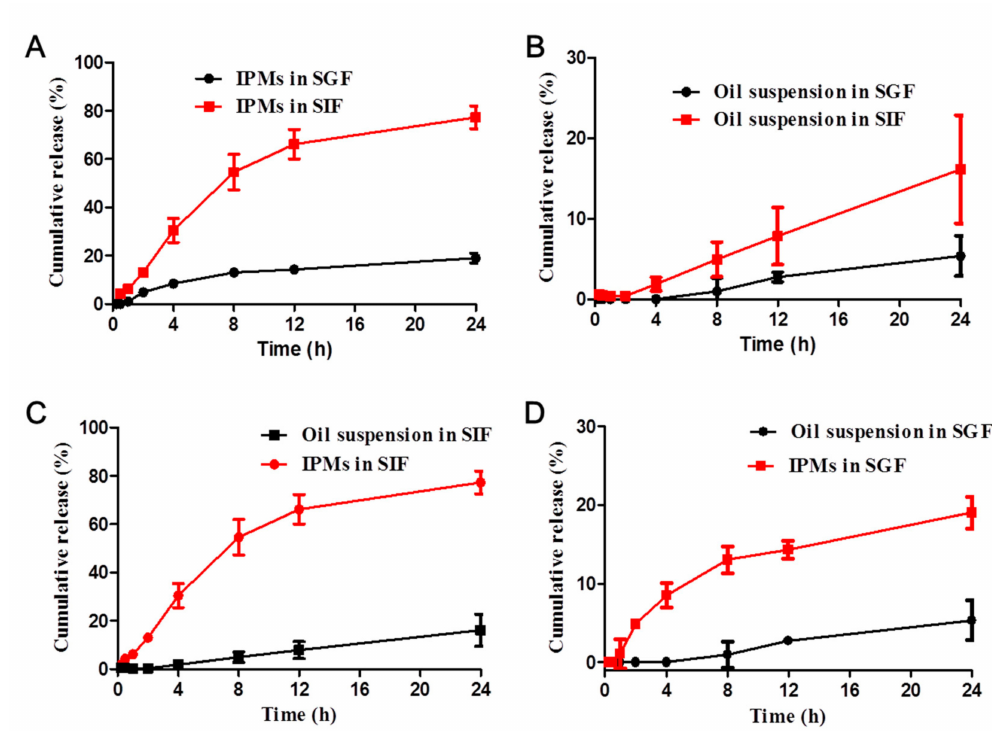
Figure 5. In vitro release profiles of IPMs ( A ) and oil suspension ( B ) in SGF ( C ) and SIF ( D ) at 37 ◦ C ( n = 3). IPMs, icaritin-loaded polymeric micelles; SGF, simulated gastric fluid; SIF, simulated intestinal fluid.